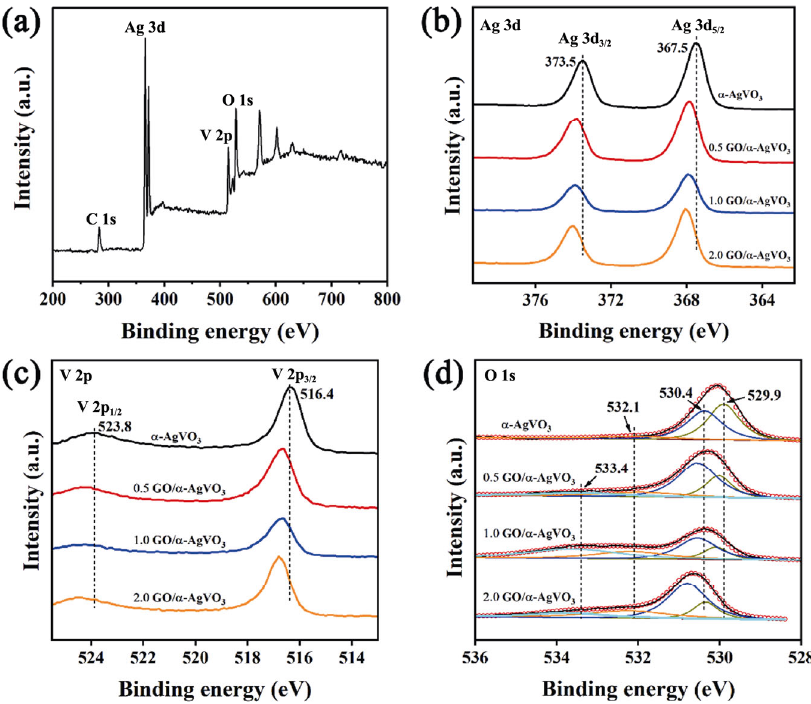
Fig. 11 (a) Full-scale XPS survey spectrum for 0.5 GO/ α -AgVO 3 and the XPS spectra of (b) Ag 3d, (c) V 2p, and (d) O 1s for GO/ α -AgVO 3 with different GO contents (0.5, 1.0, and 2.0